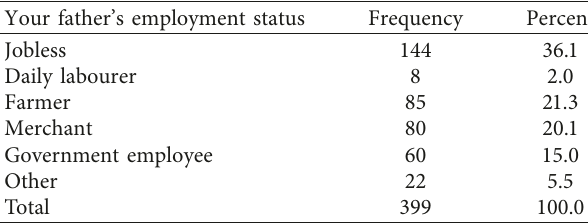
Table 3: Occupation of respondent’s